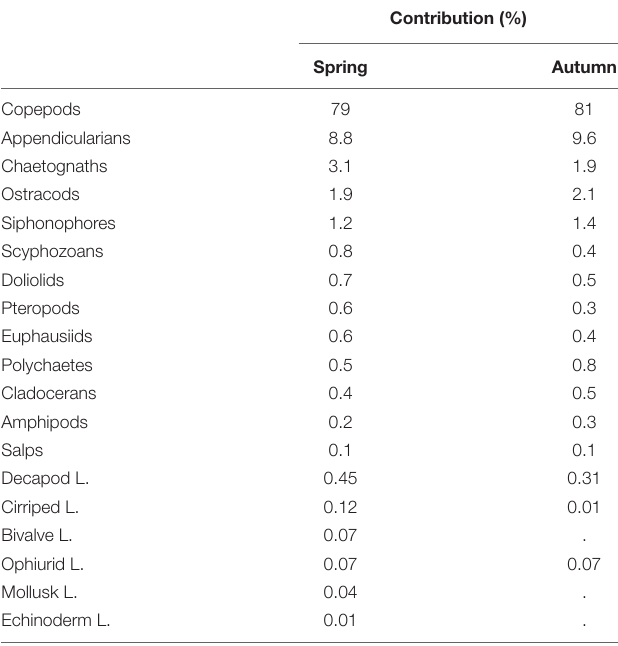
TABLE 1 | Contribution (%) of main zooplankton groups in spring and in autumn after considering all surveys over the six years of the